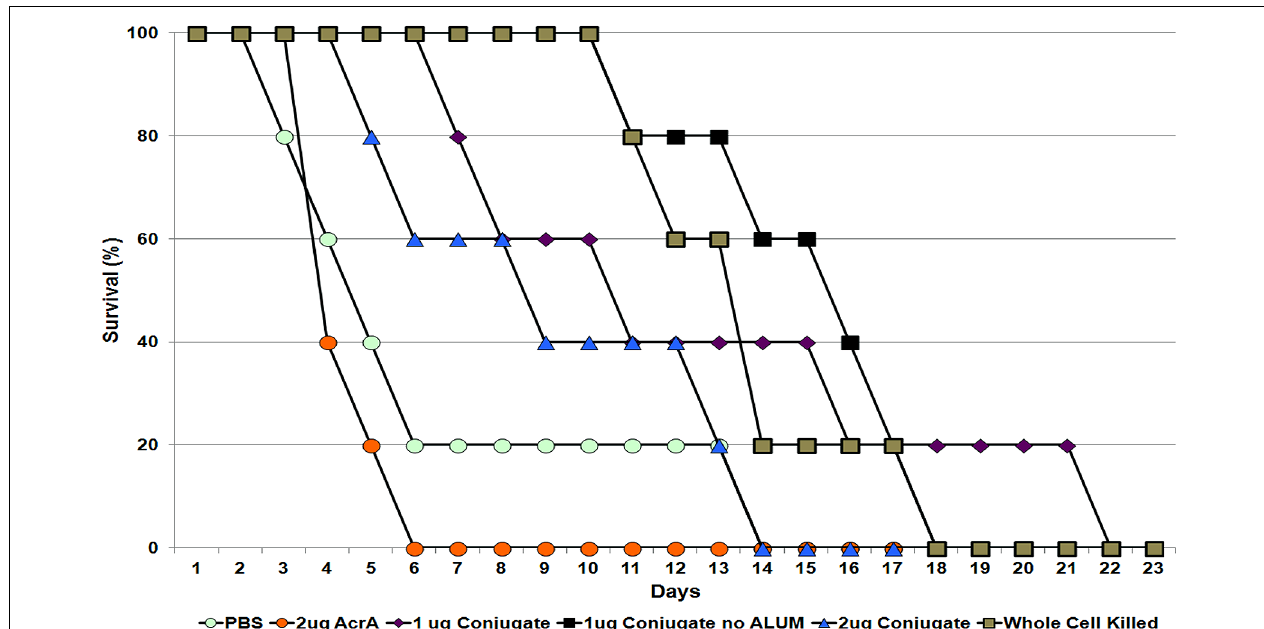
compared to the mice injected with OPS II glycosylated AcrA. Interestingly, mice vaccinated with 1 μ g glycoconjugate ( + / − adjuvant) had a higher survivorship percentage as compared to the 2 μ g vaccinated